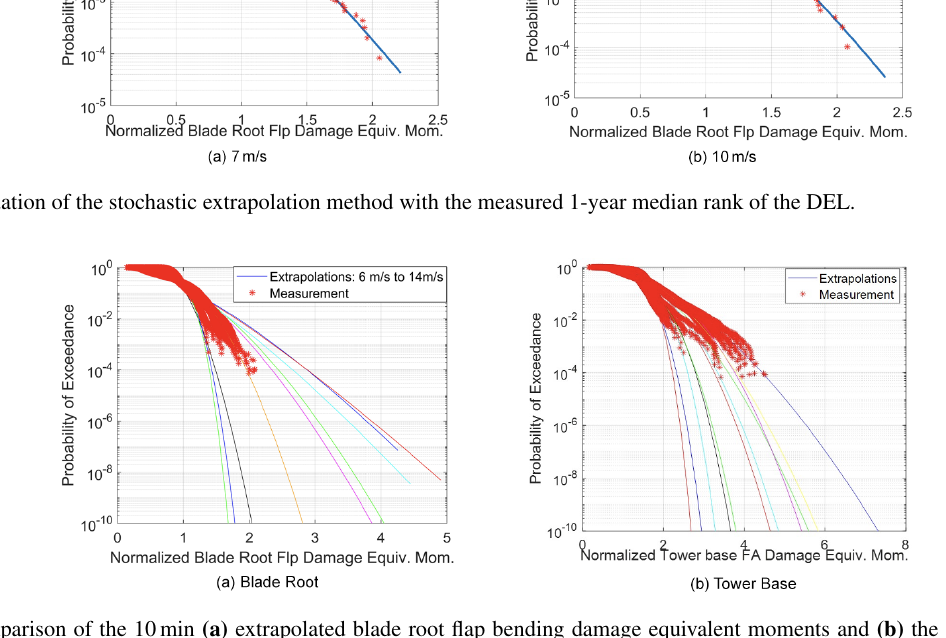
Figure 6. Comparison of the 10min (a) extrapolated blade root flap bending damage equivalent moments and (b) the extrapolated tower base fore–aft damage equivalent moments, using measurements. For the blade root, extrapolated curves begin at the far left (5ms − 1 – lowest DEL), move to the right with increasing mean wind speed until 11ms − 1 (highest DEL), and then move left again with increasing mean wind speed. For the tower base, extrapolated curves begin at the middle at 5ms − 1 and move to the right (highest DEL) until 8ms − 1 , before moving to the left